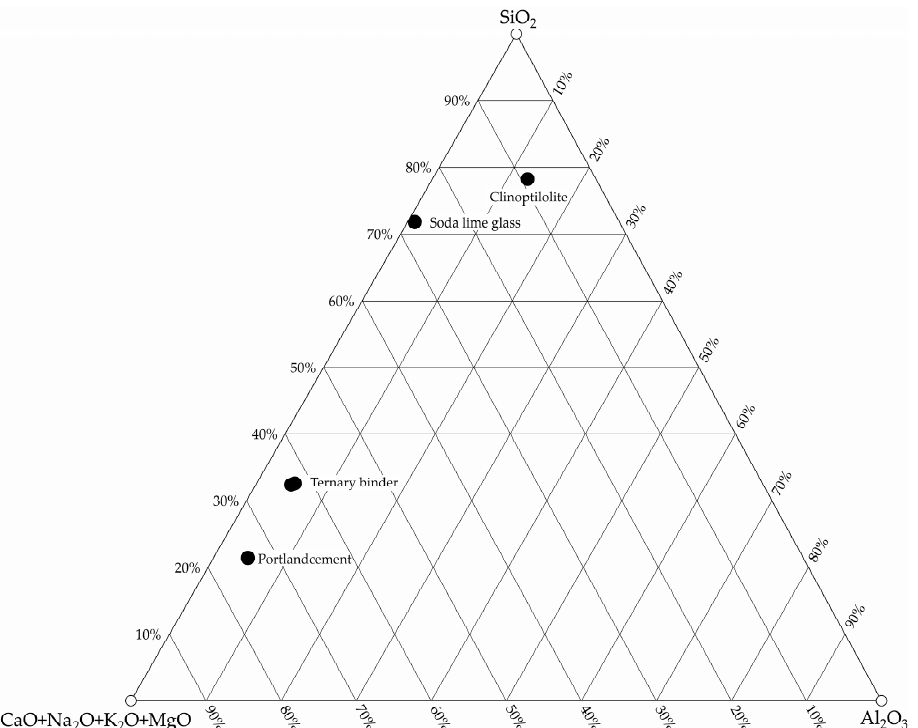
Figure 1. Ternary diagram of the binders.